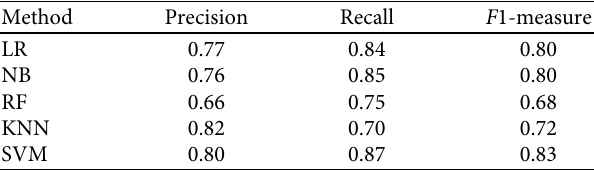
Figure 12: Fault diagnosis model training and new fault diagnosis process. Table 3: Classification effect of word feature space.